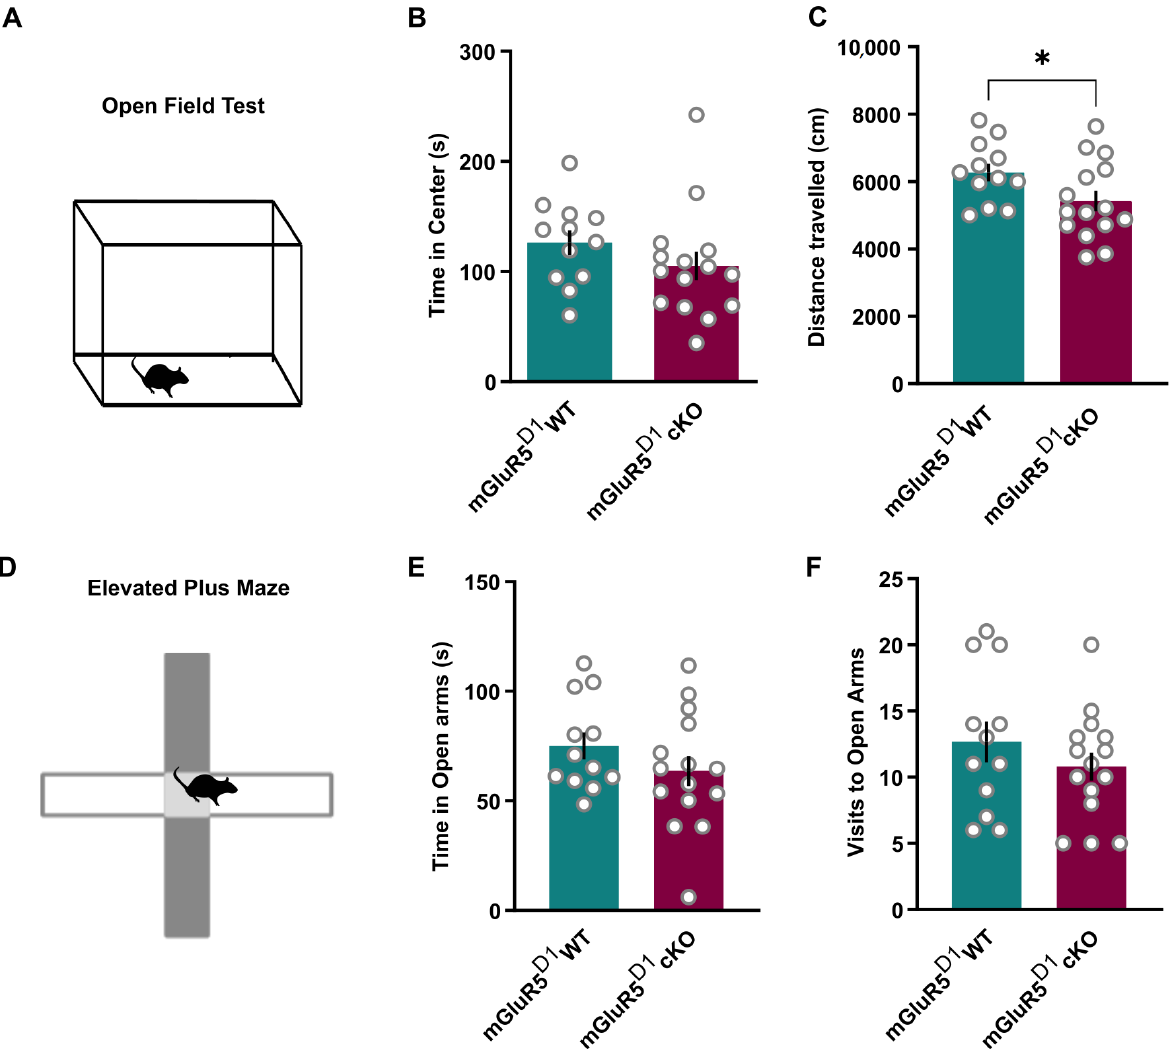
Figure 3. ( A ) Scheme of the open field test. ( B ) Time spent in the center of the open field (s). mGluR5 D1 WT and cKO mice showed similar time spent in the center of the open field. Unpaired T-test, T = 1.20, ns ( p = 0.24). ( C ) mGluR5 D1 cKO mice travelled less distance during a 20 min test in an open field as compared to their WT littermates. Unpaired T-test, T = 2.086, p = 0.047. ( D ) Scheme of the elevated plus maze. ( E ) Time spent in the open arms of the maze (s). mGluR5 D1 WT and cKO mice showed similar anxiety-like behavior as measured with time spent in the open arms: Unpaired T-test, T = 1.22, ns ( p = 0.23). ( F ) Visits to the open arms of the maze. mGluR5 D1 WT and cKO mice showed similar anxiety levels as measured with time spent in the open arms: Mann–Whitney test, U = 71.5, ns ( p = 0.38). n = 12 mGluR5 D1 WT, M * p ≤